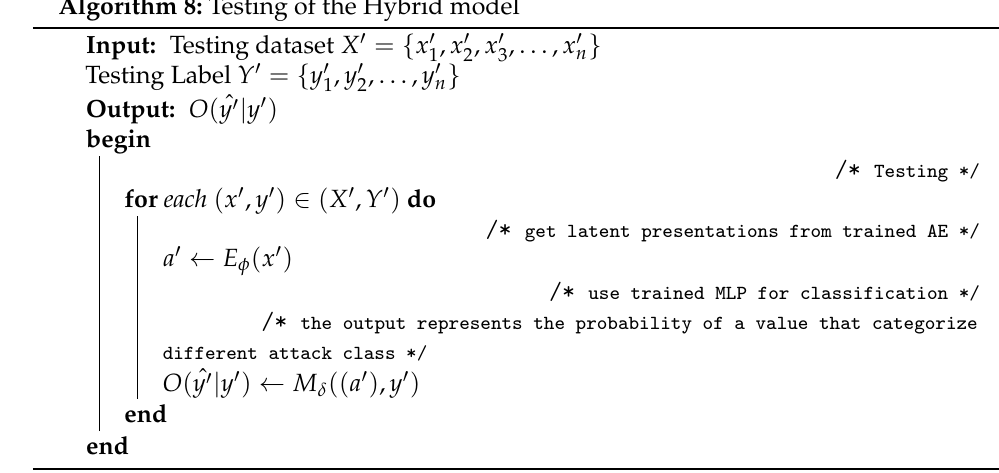
Algorithm 8: Testing of the Hybrid